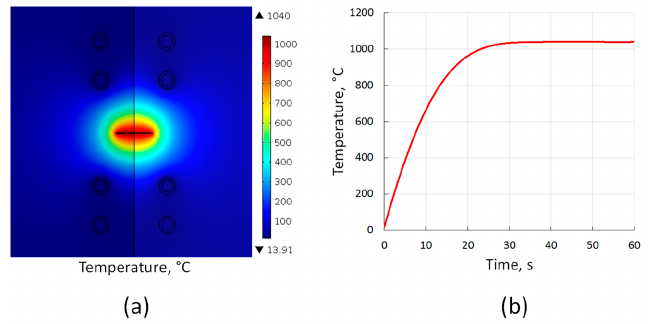
Figure 11. ( a ) Temperature distribution in the induction heating system after 60 s. ( b ) Calculated copper foil surface temperature evolution during heating.